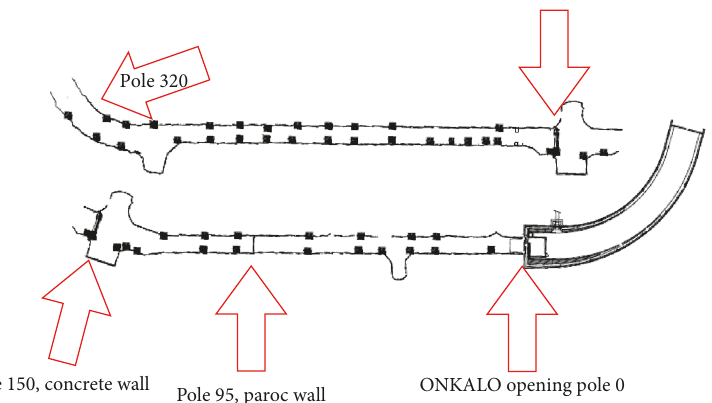
Figure 12: Measurement configuration 3.